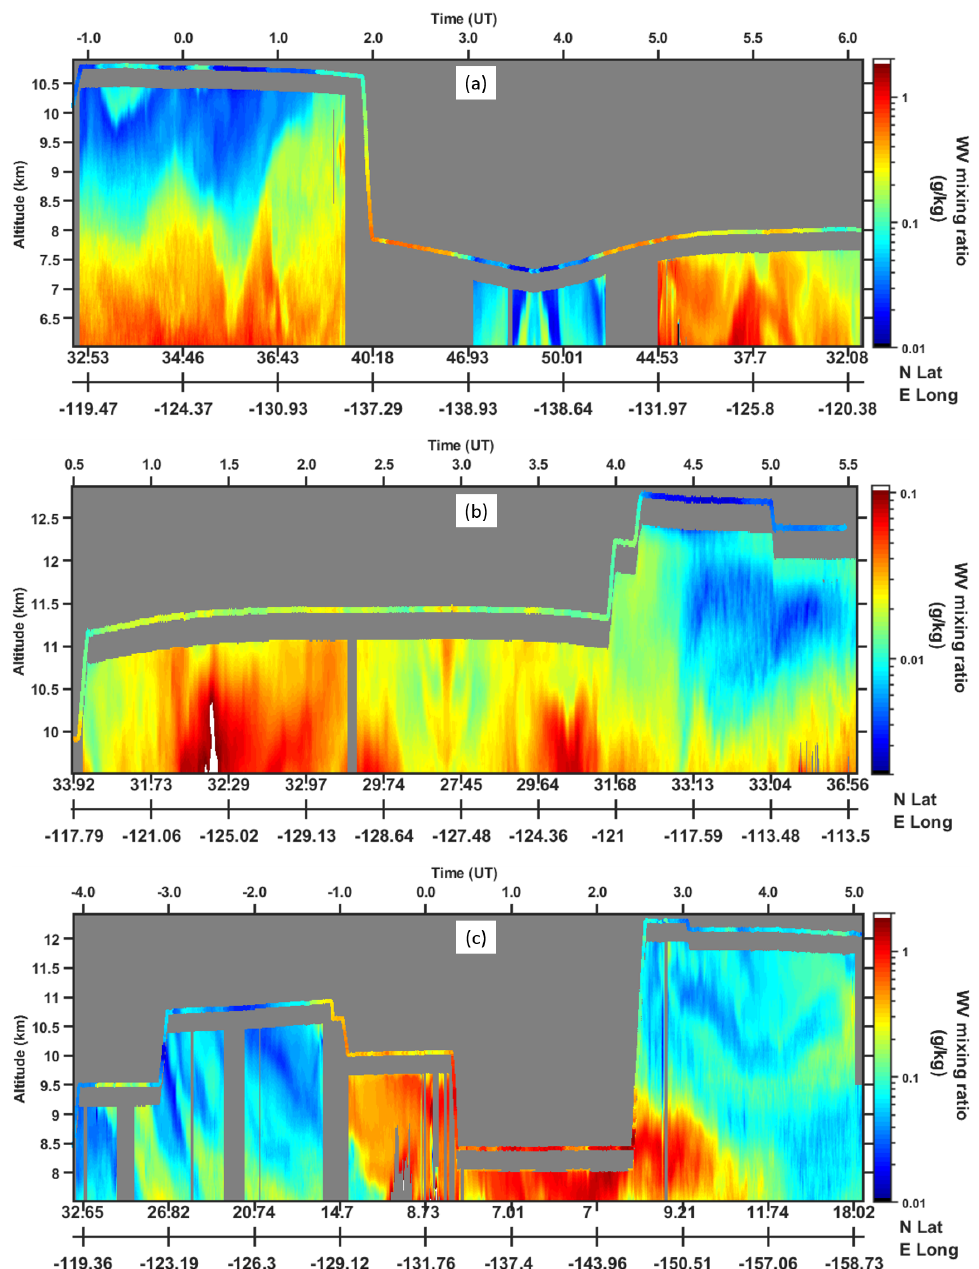
Figure 8. HALO WV curtains with DLH plotted at the aircraft altitude, as in Fig. 4a. Segments of three different flights are shown in ( a , 18 April; b , 23 April) midlatitudes and ( c , 26 April) the tropics. Only upper altitudes are shown to focus on comparison with